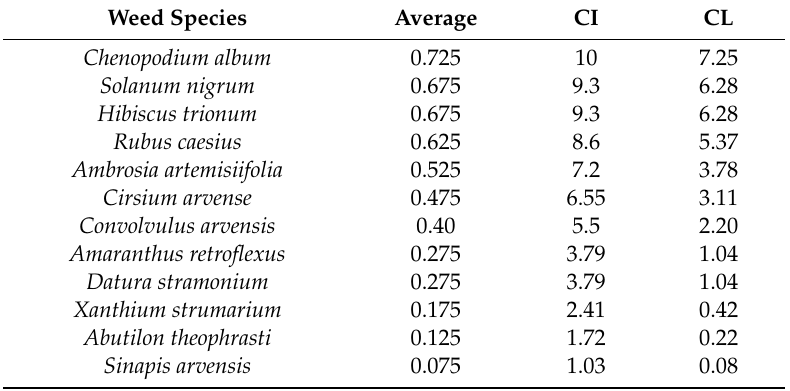
Table 8. Competitive index and competitive load for broadleaf weeds in